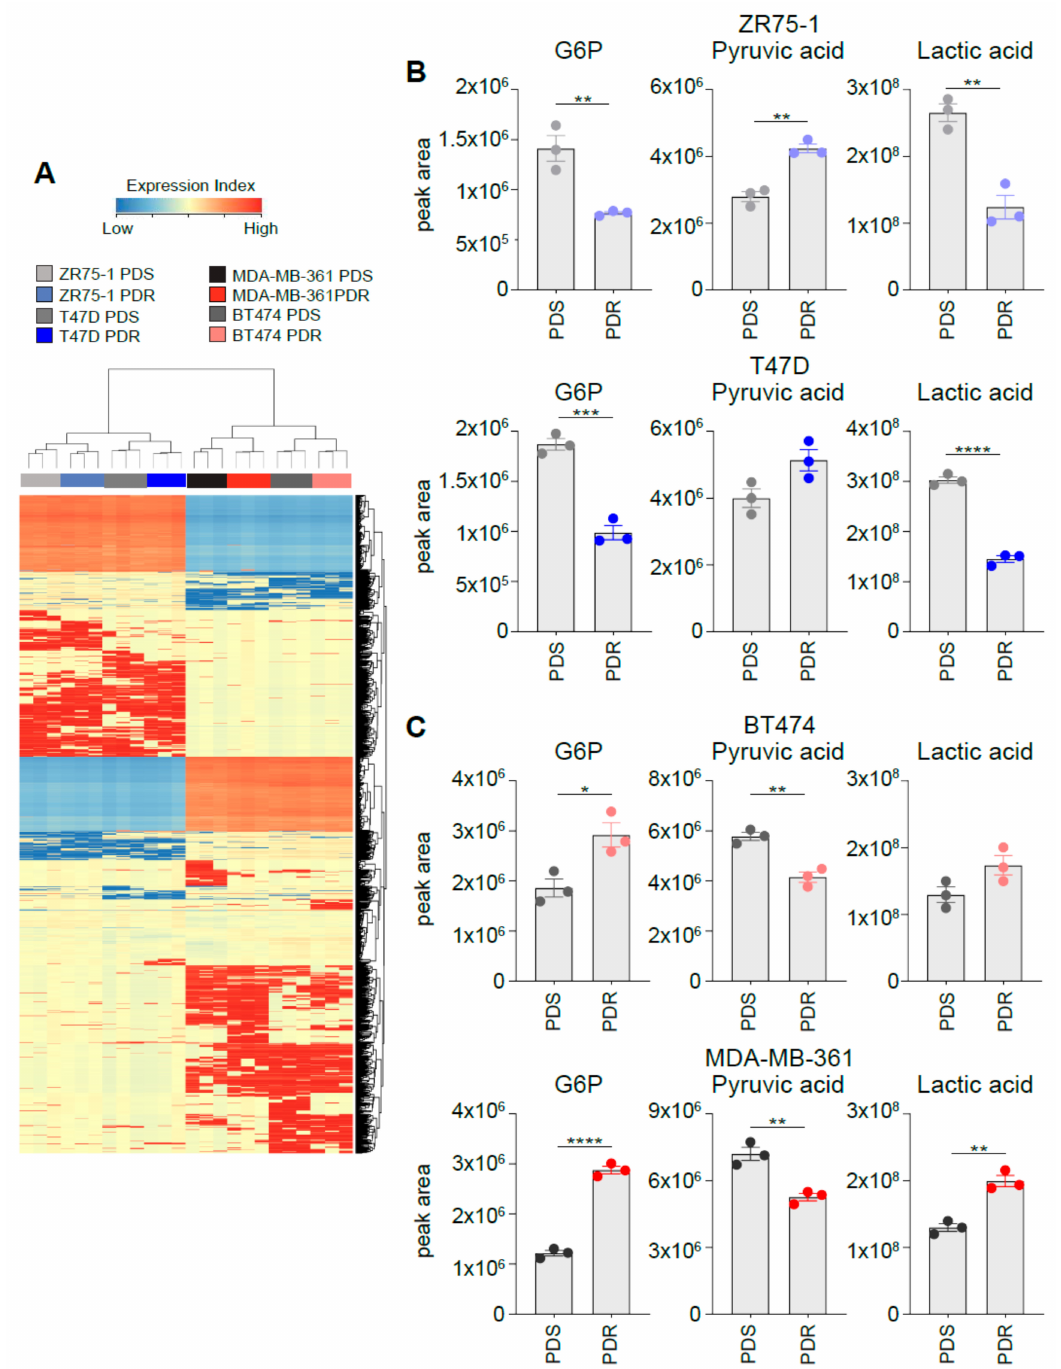
Figure 7. Metabolomic profiling identifies a distinct intracellular metabolites pattern between HER2 +